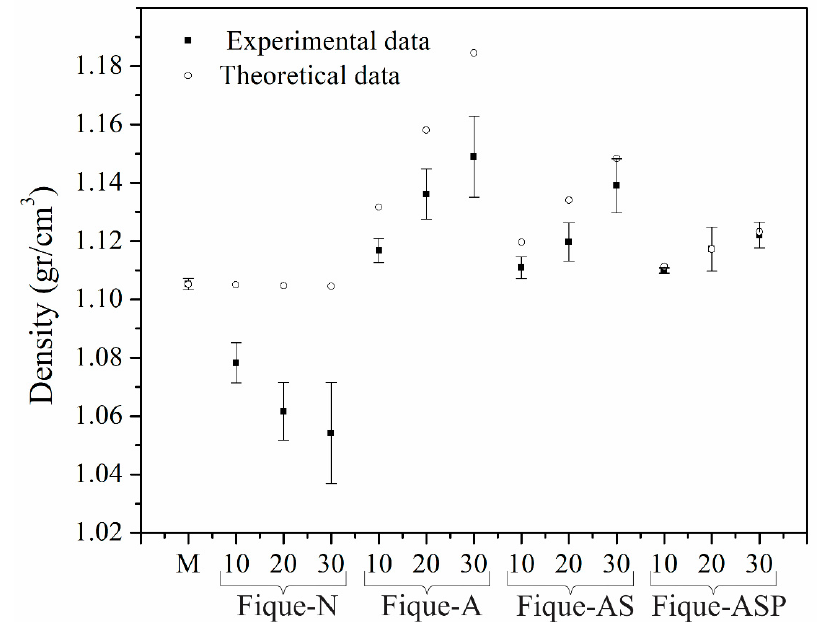
Figure 4. Density of the low-density polyethylene (LDPE)-Al and composites with 10%, 20%, and 30% fique fiber with or without surface modification. fique fiber with or without surface